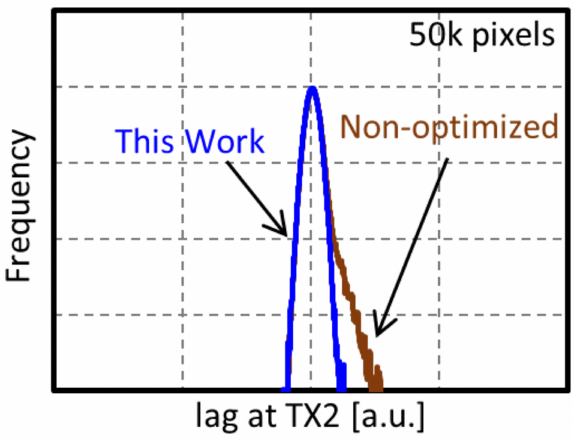
Figure 10. Image lag distribution at TX2.